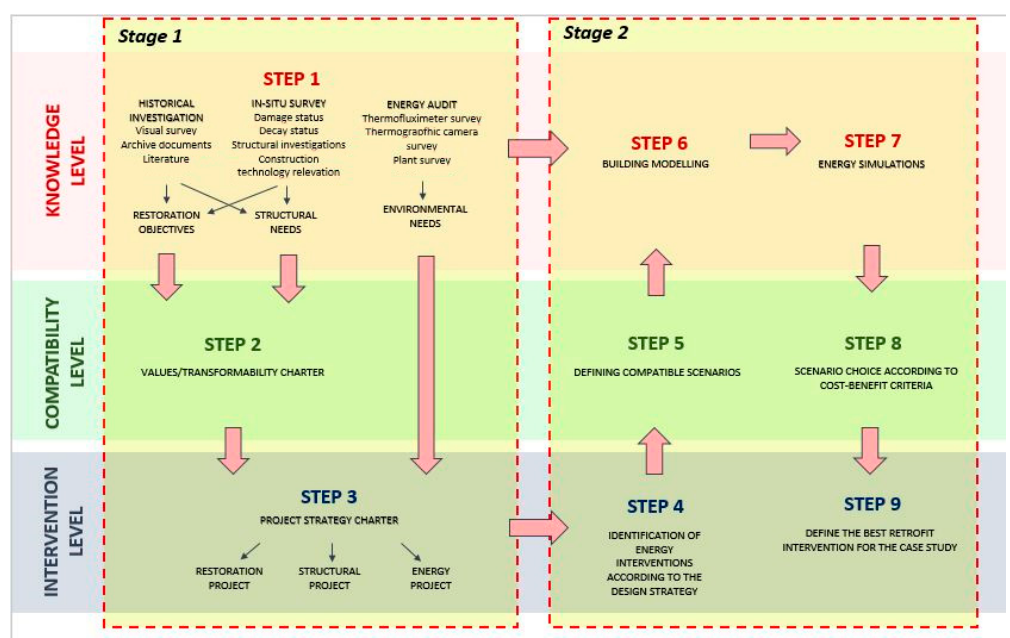
Figure 1. Methodolgy applied in the optimization of energy retrofit interventions.